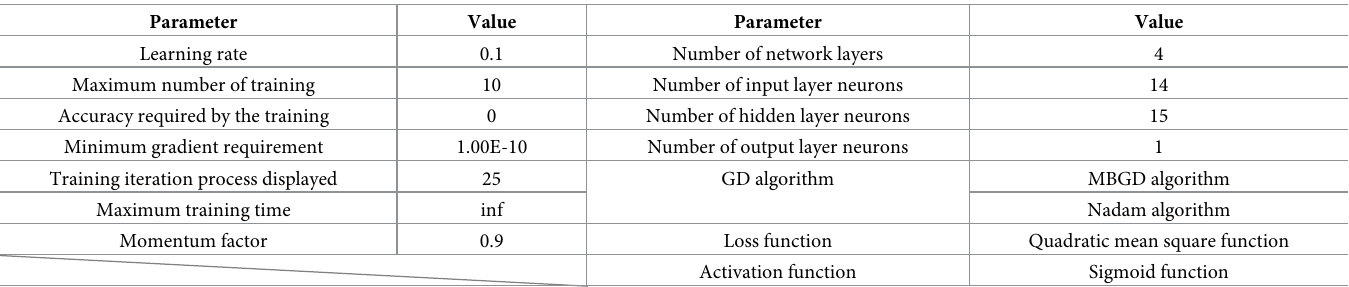
Introduction to experimental